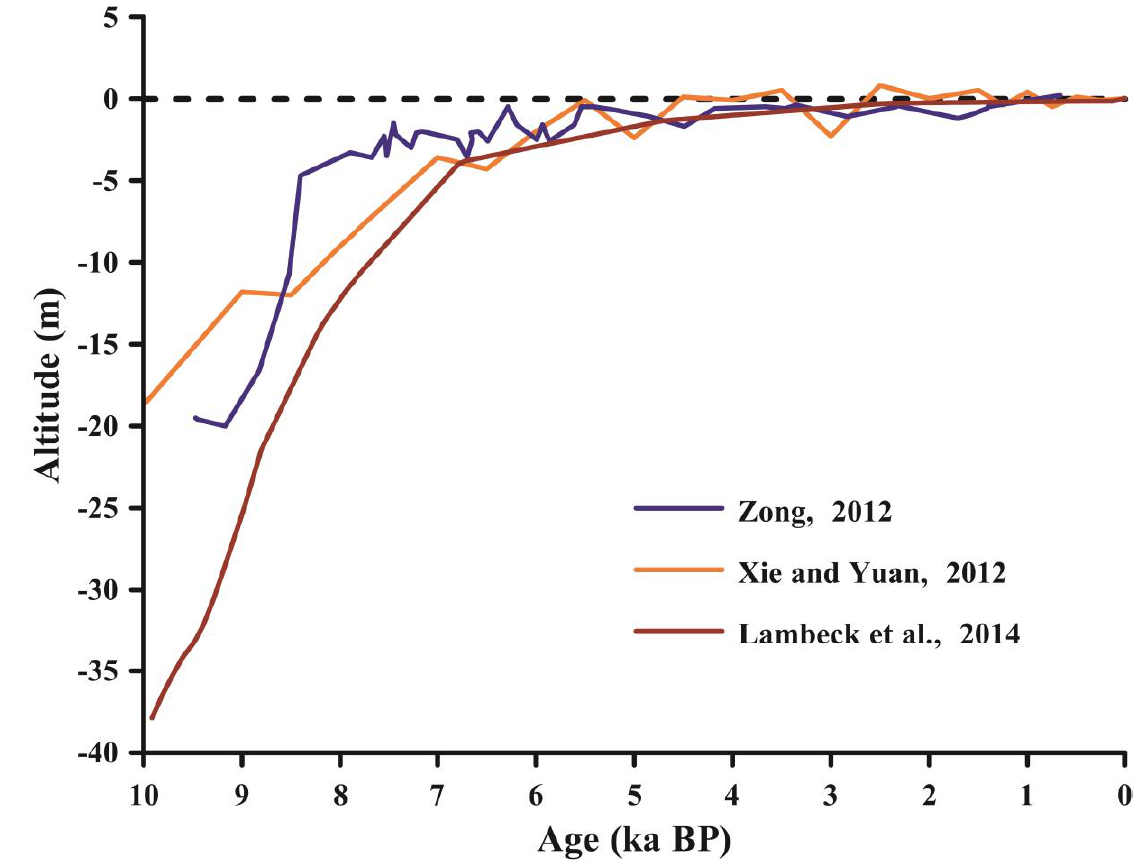
Figure 6. Curves of sea level changes during the Holocene in East China and comparison with the global